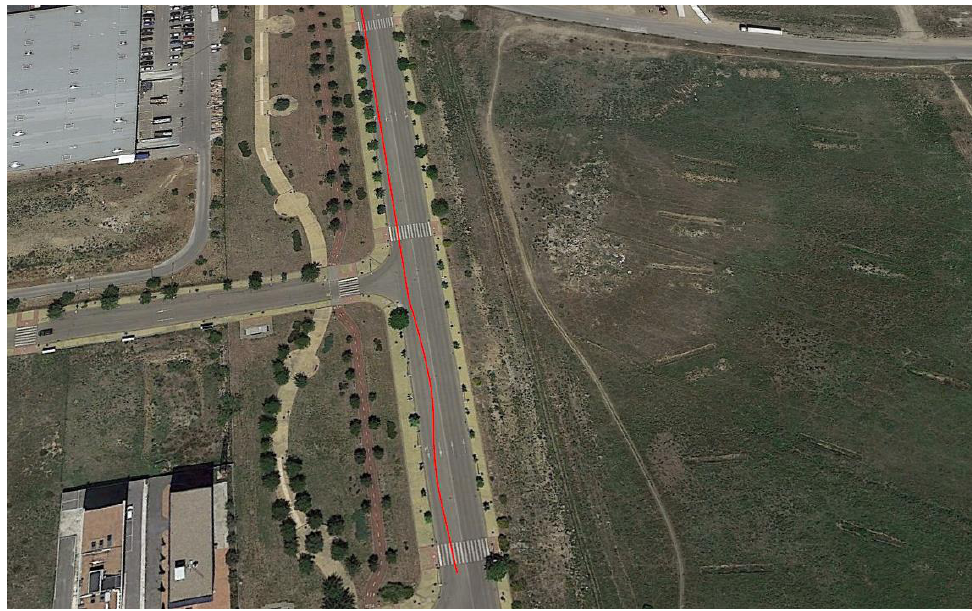
Figure 9. Test 2: Map and vehicle trajectory (Map scale 1:2100 cm).